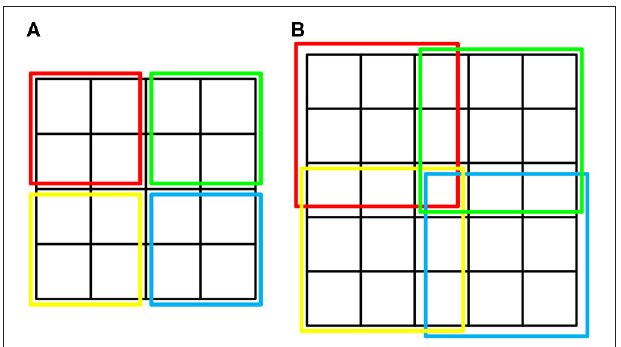
FIGURE 2 | A diagram of preprocessing for each slice.